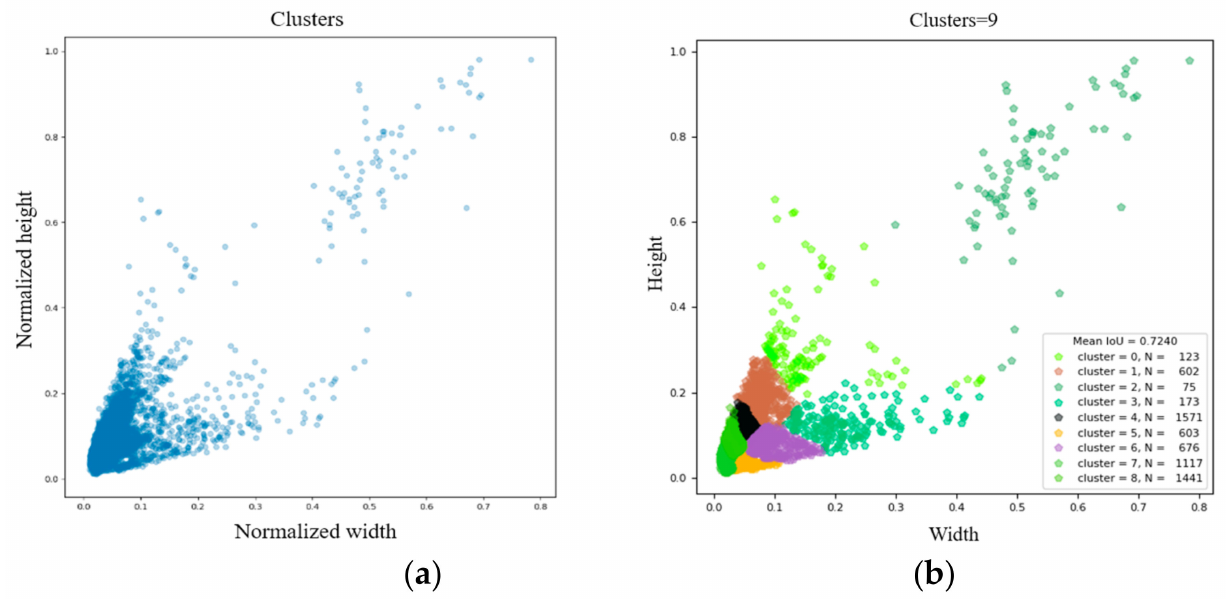
Figure 2. K-means clusters result: ( a ) the size distribution of the drones on the UAV dataset labeled boxes; ( b ) the clustering result of the anchor